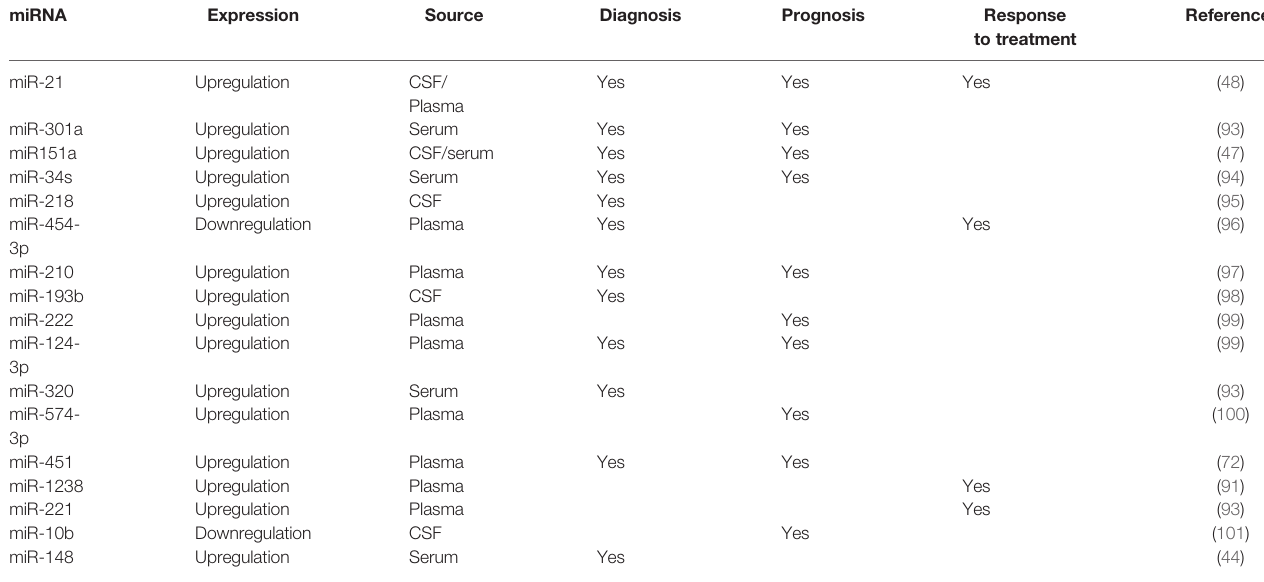
TABLE 2 | Clinical application of exosomal miRNA in glioma.